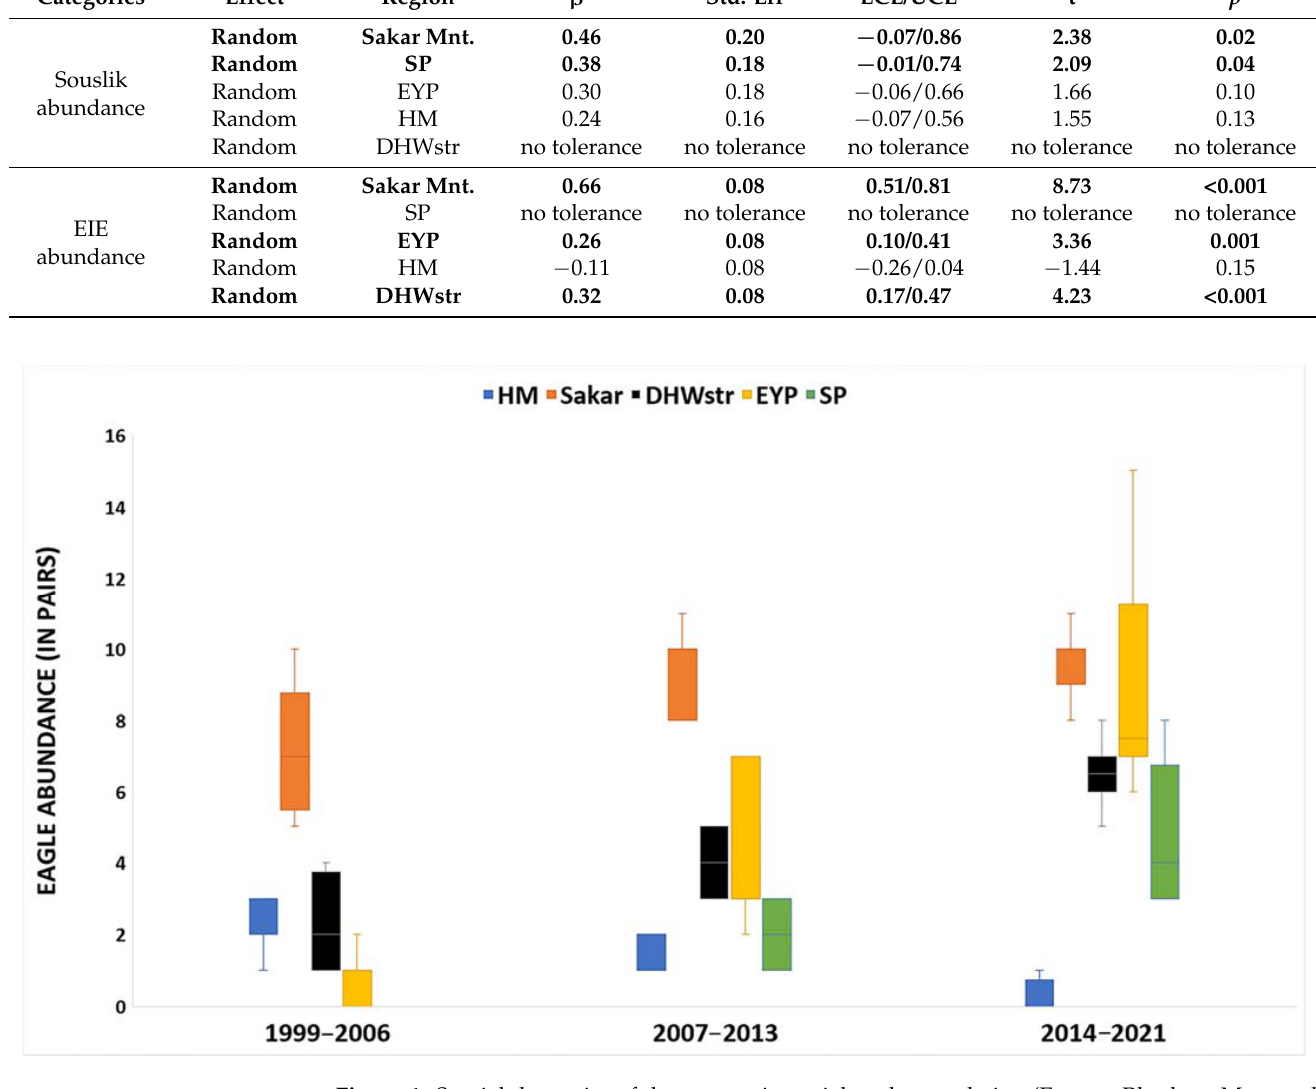
Figure 4. Spatial dynamics of the eastern imperial eagle population (Eastern Rhodope Mnt. and Sredna Gora Mnt., HM; Sliven plain, SP; Elhovo ‐ Yambol plain, EYP; Dervent Heights ‐ Western foothills of Strandzha Mnt., DHWstr; Sakar Mnt.).